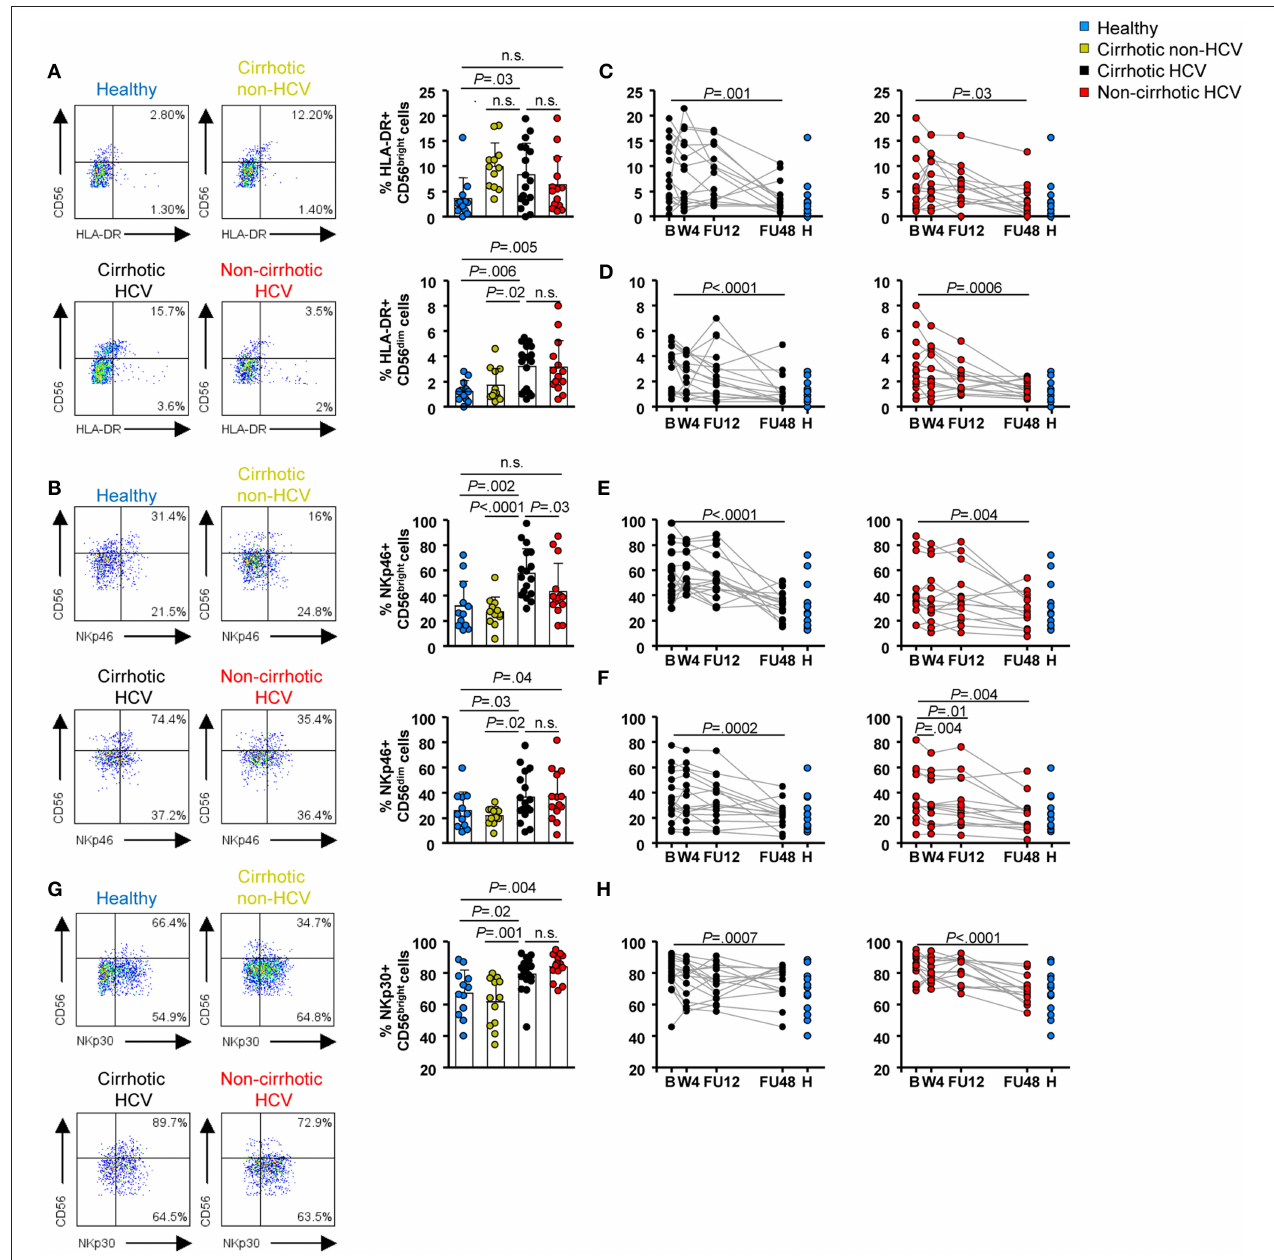
FIGURE 2 | Activating receptor frequencies within NK subpopulations were upregulated at baseline in HCV patients with cirrhosis and persisted until FU48. Flow cytometric analysis of PBMC samples from 12 healthy individuals (blue), 12 non-HCV cirrhotic controls (yellow), 17 HCV cirrhotic (black), and 14 non-cirrhotic (red) patients. Representative flow cytometry plots and baseline frequencies of HLA-DR + (A) , NKp46 + (B) , and NKp30 + (G) CD56 bright (above) and CD56 dim (below) cells. Longitudinal analysis during and after IFN-free therapies of HLA-DR + CD56 bright cells (C) , HLA-DR + CD56 dim cells (D) , NKp46 + CD56 bright cells (E) , NKp46 + CD56 dim cells (F) , and NKp30 + CD56 bright cells (H) . Error bars indicate mean + SD; P -values at baseline were determined by Mann–Whitney U test; P -values during longitudinal analysis were determined by mixed models for repeated measurements. n.s., not significant.